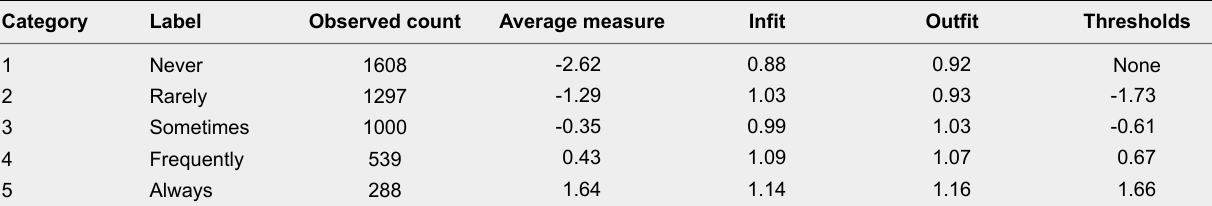
Rasch Diagnostics for the Category